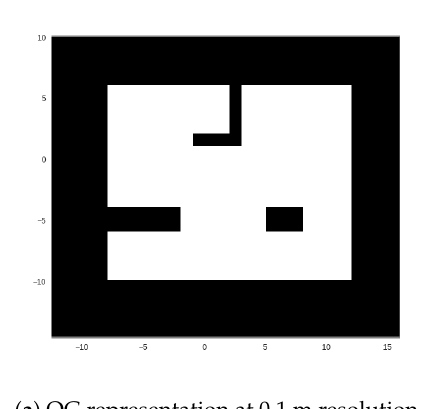
Figure 2. Comparison between OG and HM representation queried at same resolution. Notice that rounded corners are not the most desirable representation for structured environments, but for underwater scenarios is not usually a